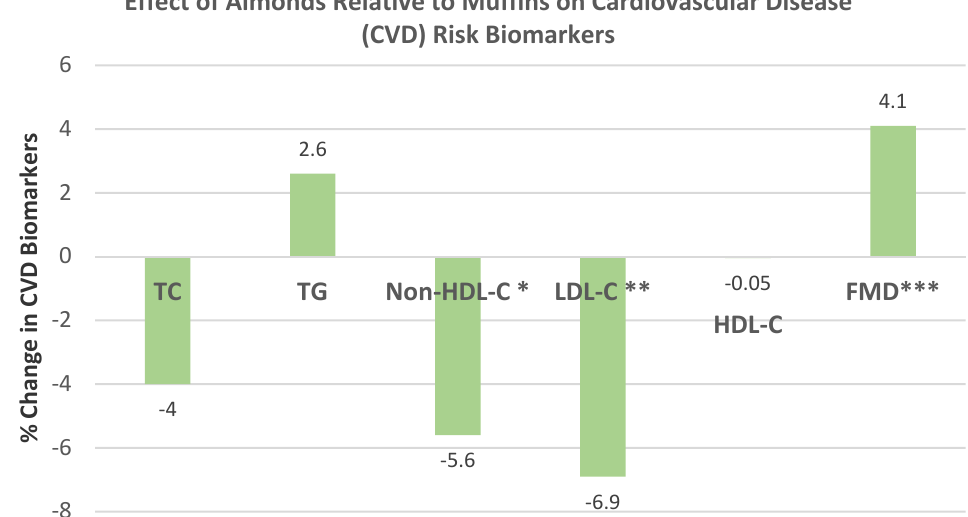
Figure 20. Changes in % mean CVD risk biomarkers for the almond diet compared to the muffin control diet from baseline to 6 weeks (* p = 0.037, ** p = 0.017, *** p < 0.00005) [45]. Eight to Twenty-Four weeks